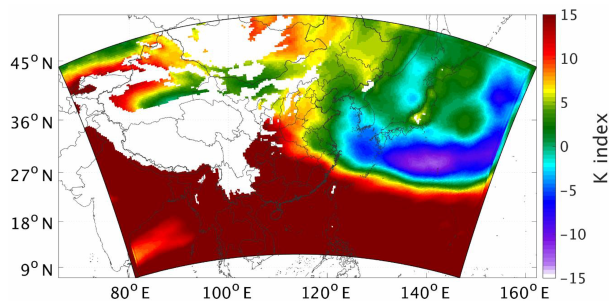
Figure 10. Spatial distributions of the monthly average K index from NO-DUST/CLOUD.